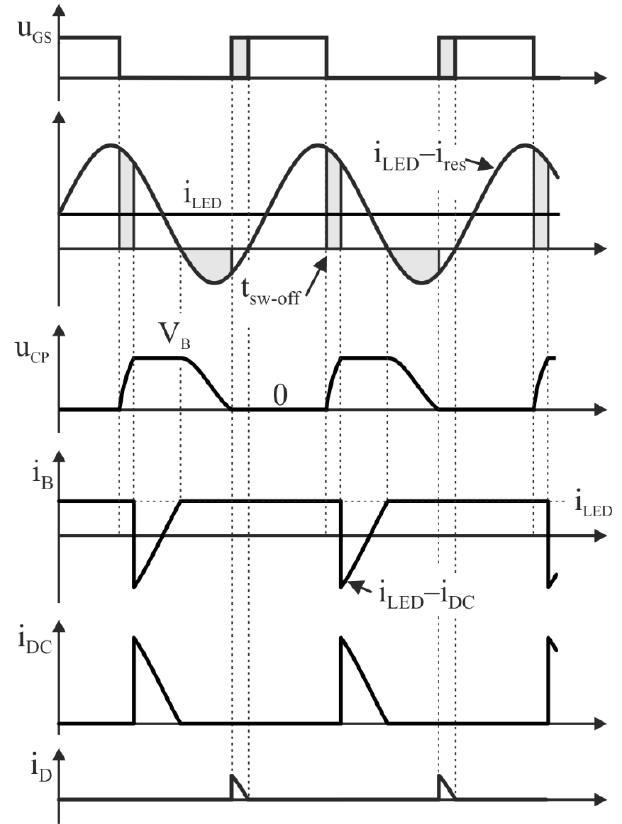
Figure 2. Circuit Figure 2. Circuit waveforms.